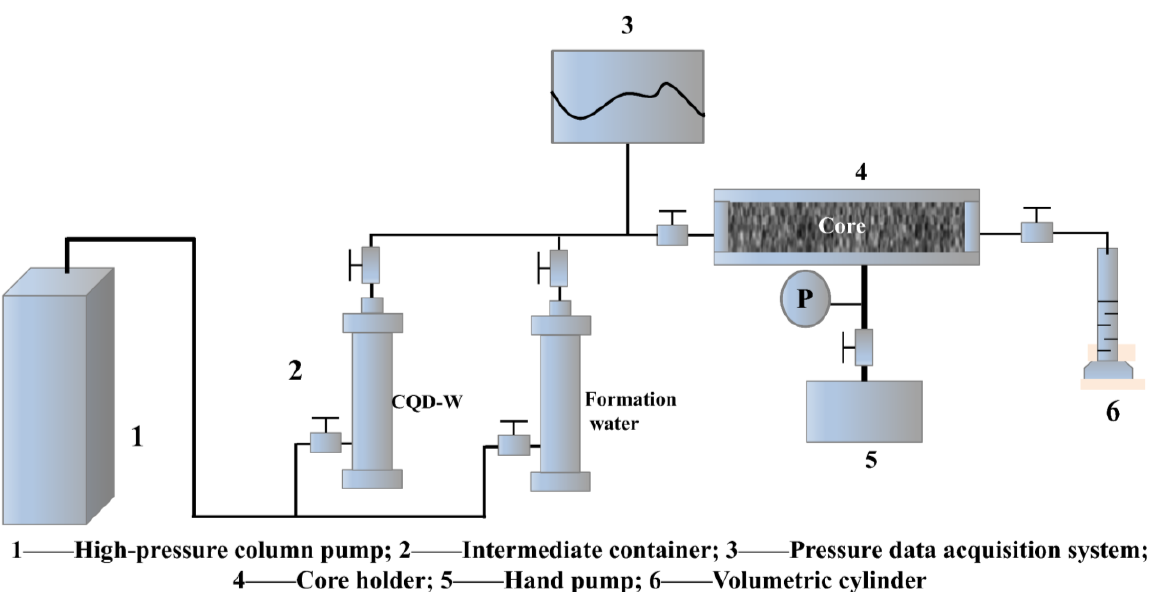
Figure 1. Schematic diagram of core flow device.